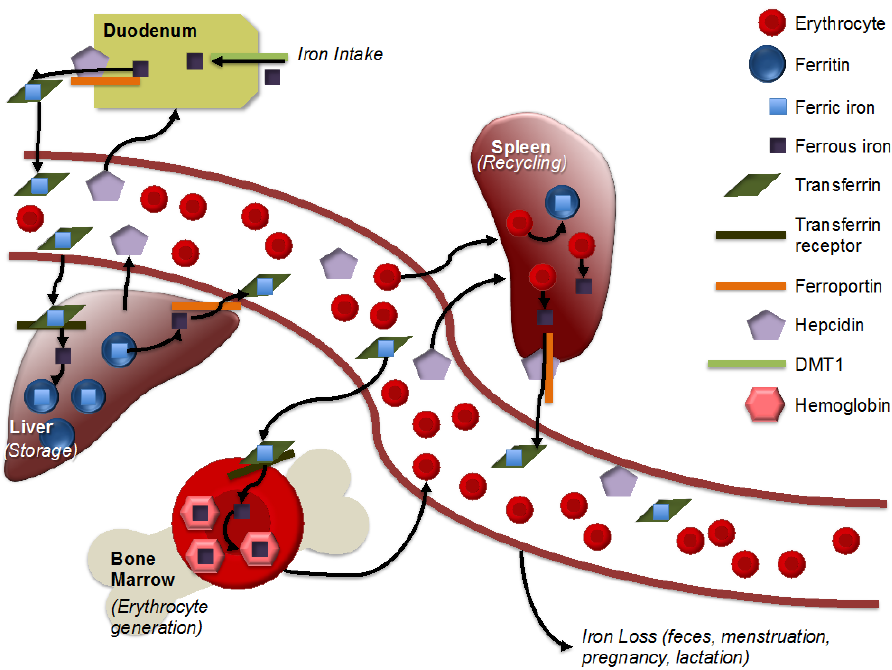
Figure 1. Simplified representation of iron metabolism. Adapted from [12]. Iron is absorbed in the intestine, with non-heme iron being imported by divalent metal transporter 1 (DMT1). Ferrous iron is reduced to ferric iron and then exported by ferroportin. Within an aqueous solution, iron is stored within transferrin. Transferrin-bound iron is imported with the help of the transferrin receptor into the liver, heart and other storage areas, where it is stored within ferritin. Hepcidin, produced by the liver, helps to regulate iron metabolism by binding to ferroportin and, thus, inhibiting iron export. Within the bone marrow, iron is incorporated into hemoglobin for incorporation into erythrocytes. Macrophages recycle iron from erythrocytes, largely in the spleen. There is no mechanism for iron excretion by the kidneys or liver, though small amounts are lost via feces. Menstruation, pregnancy and lactation result in iron loss in